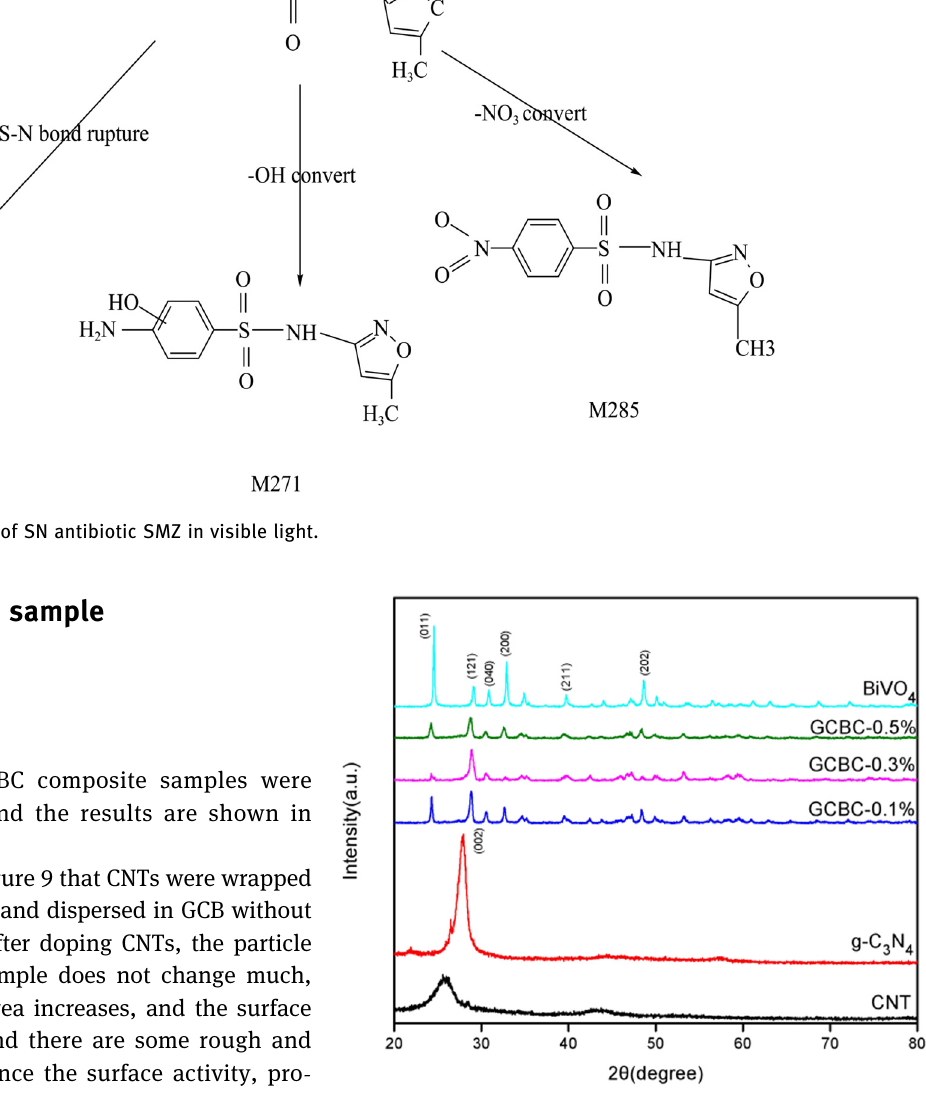
Figure 10: XRD diagram of g - C 3 N 4 , BiVO 4 , and GCBC composite